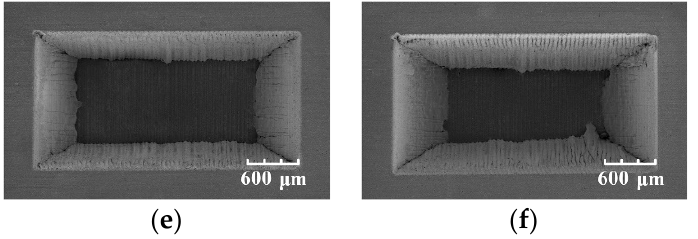
Figure 7. SEM of workpieces processed a different number of times by a blowing-assisted laser after ultrasonic cleaning: ( a ) 100 times, ( b ) 200 times, ( c ) 300 times, ( d ) 400 times, ( e ) 500 times, ( f ) 600 times.